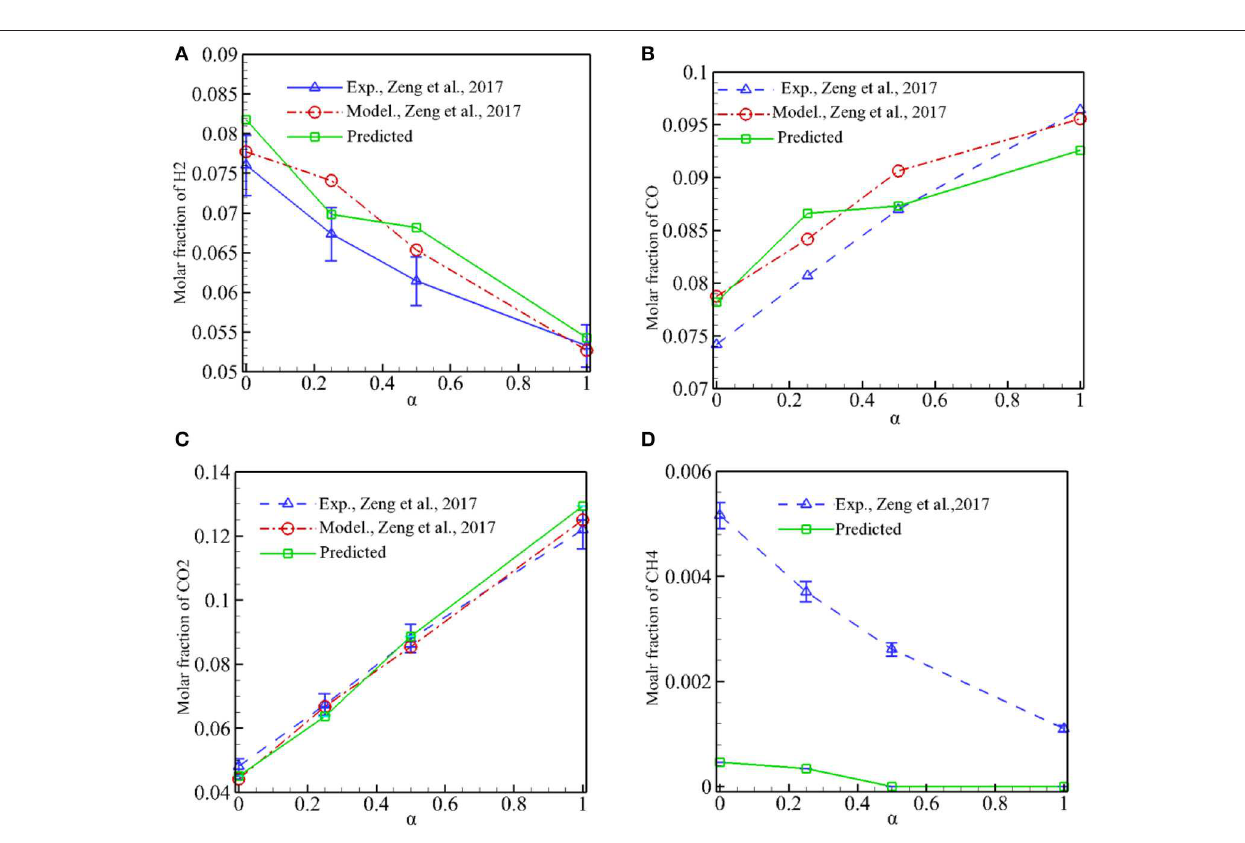
0 and φ 1.5. (B) Predicted temperatures for α = =